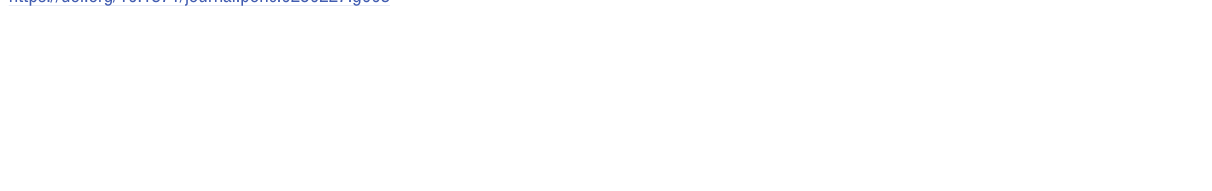
PLOS ONE | https://doi.org/10.1371/journal.pone.0250227 May 5,